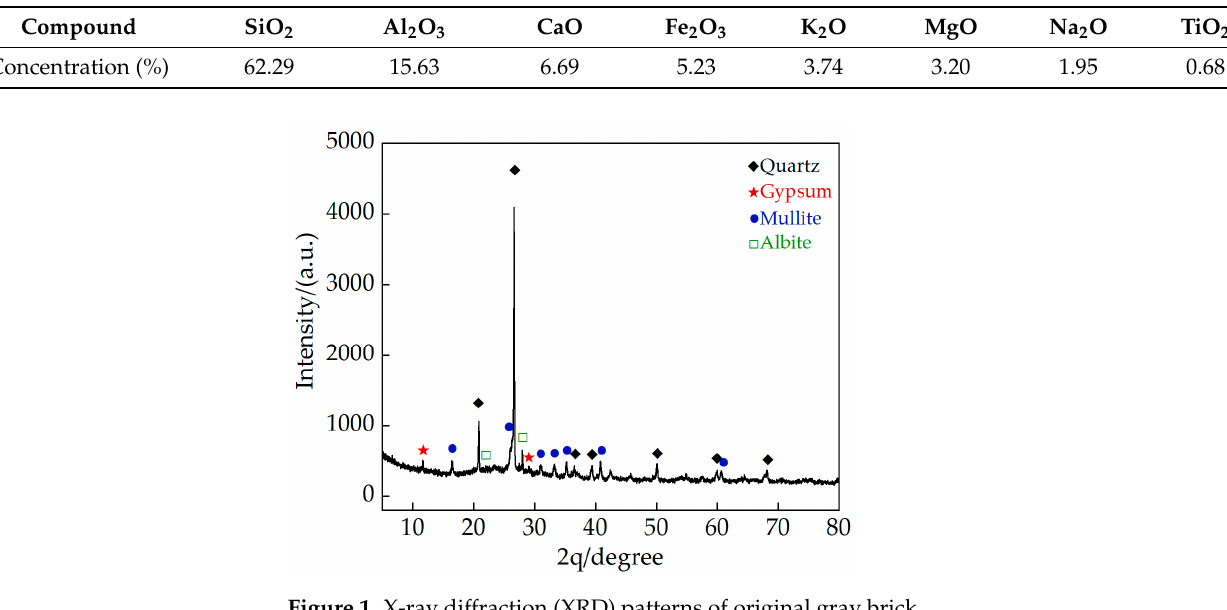
Table 1. Main chemical composition of gray brick.